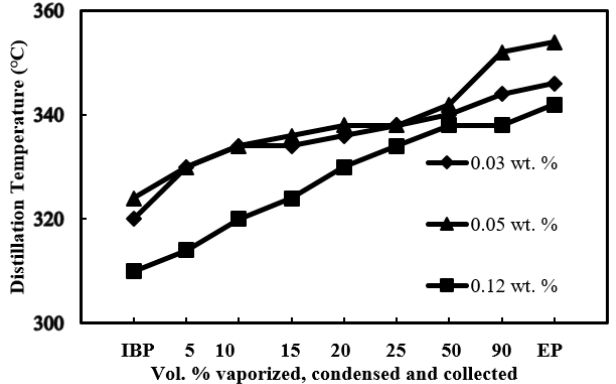
Figure 7. E ff ects of added water content in palm oil on the distillation temperature curve of the biodiesel product.